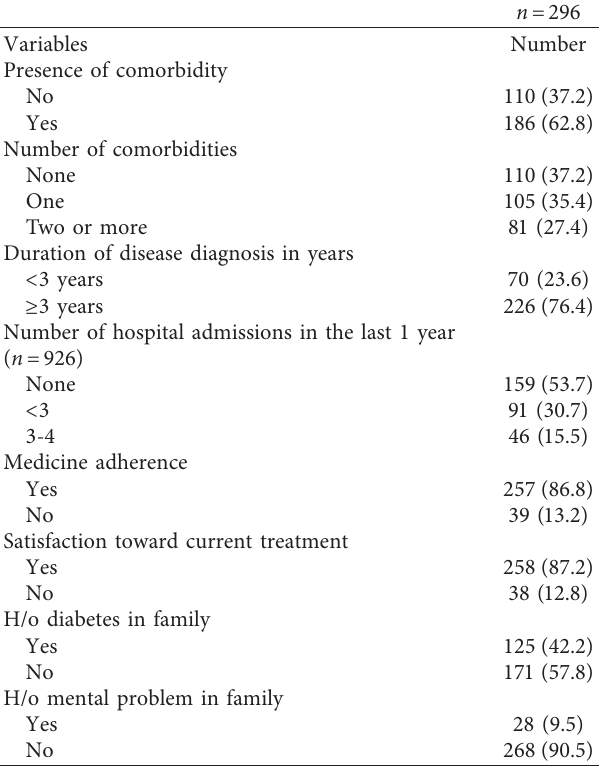
Table 2: Disease-related characteristics of patients.